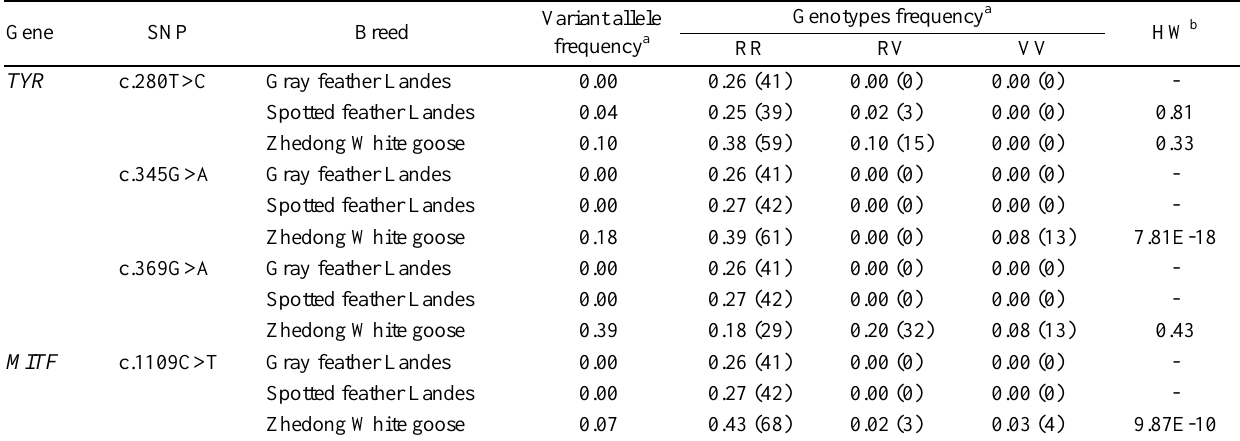
Table 2. The genetic polymorphisms in TYR gene and MITF gene Gene